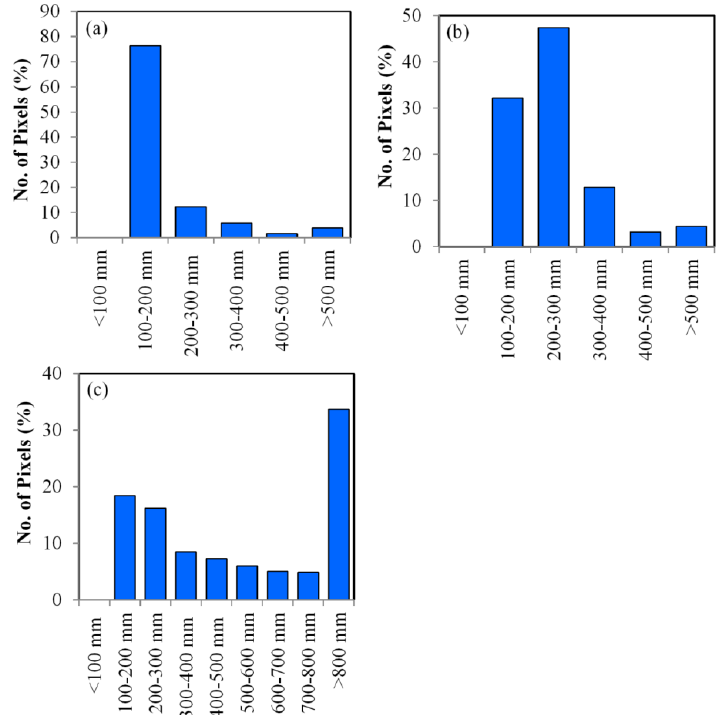
Figure 5. Histogram of the annual evapotranspiration for selected land cover classes ( a ) Barren land; ( b ) Grassland; and ( c ) Cropland within the Landsat path